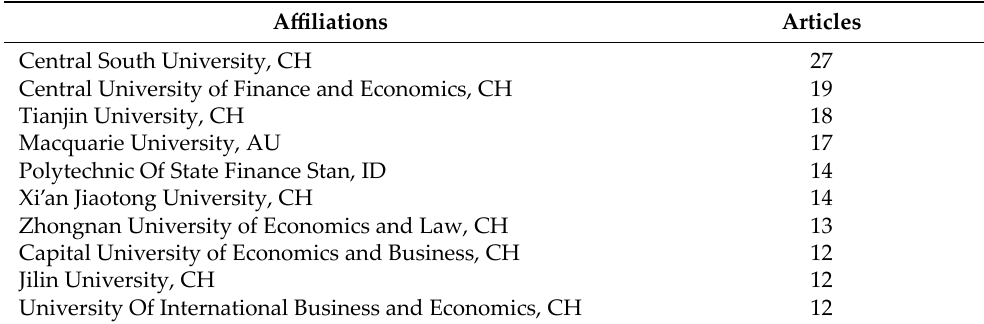
Table 3. Top 10 relevant affiliations based on the number of publications. Source: Scopus/Biblioshiny (Own elaboration).